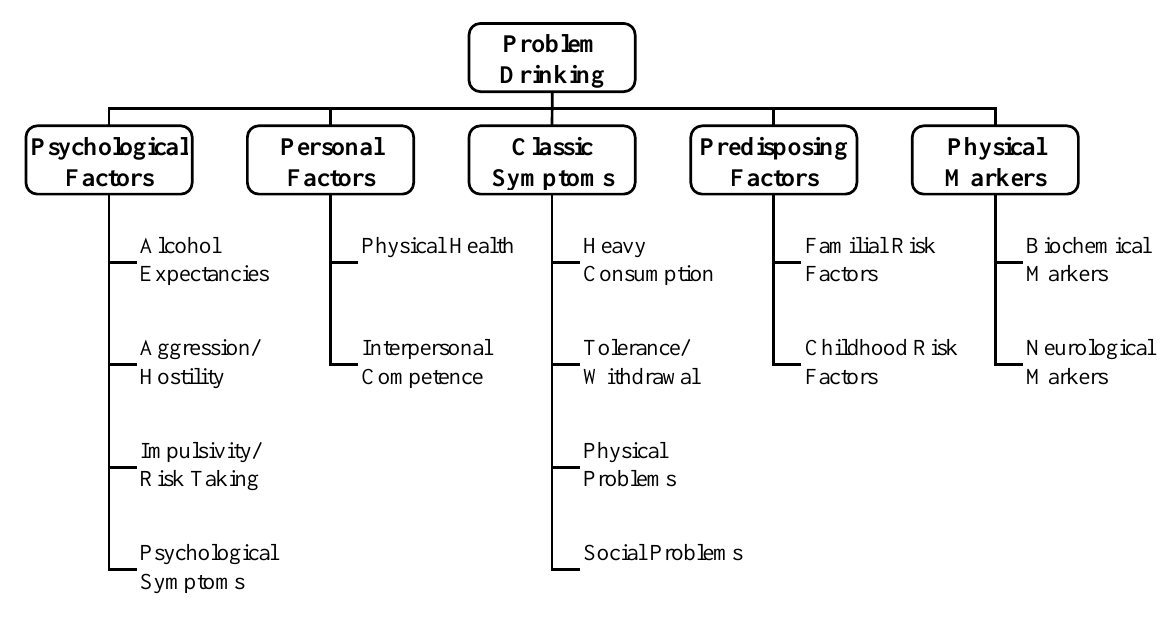
Figure 1. Content domains sampled in construction of the